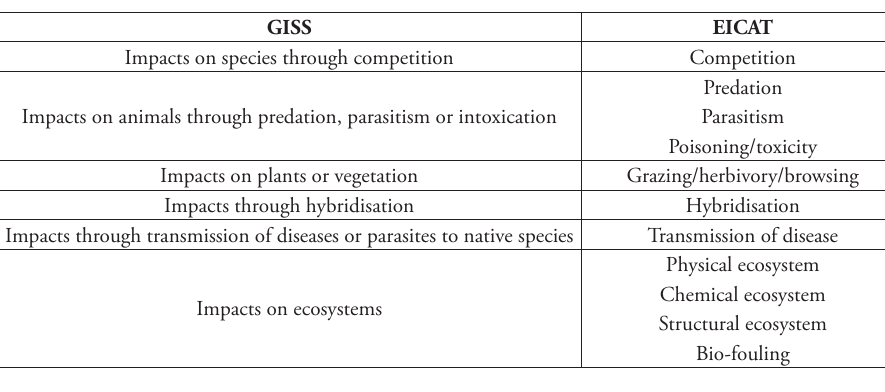
Table 1. Concatenation of the environmental impact mechanisms in GISS and EICAT that are similar following Nentwig et al. (2016) and Hawkins et al. (2015), as used to compare detailed outcomes of the two scoring schemes for each source or information. “Interaction with other alien species” in EICAT could not be attributed to specific mechanisms in GISS and was therefore not included